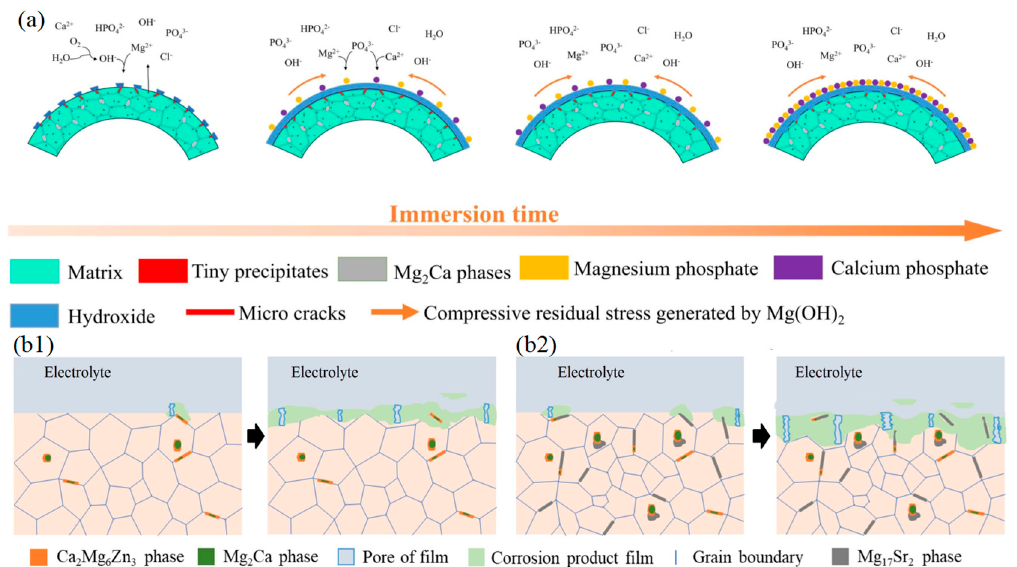
Figure 3. ( a ) Schematic diagrams illustrating the corrosion process of bent Mg − Ca − La alloys [33]; schematic illustration of Sr addition on the microstructure and corrosion process of the ( b1 ) Mg − Zn − Ca and ( b2 ) Mg − Zn − Ca − Sr alloys [38]. Reprinted with permission from refs. [33,38]. Copyright 2022 Elsevier.